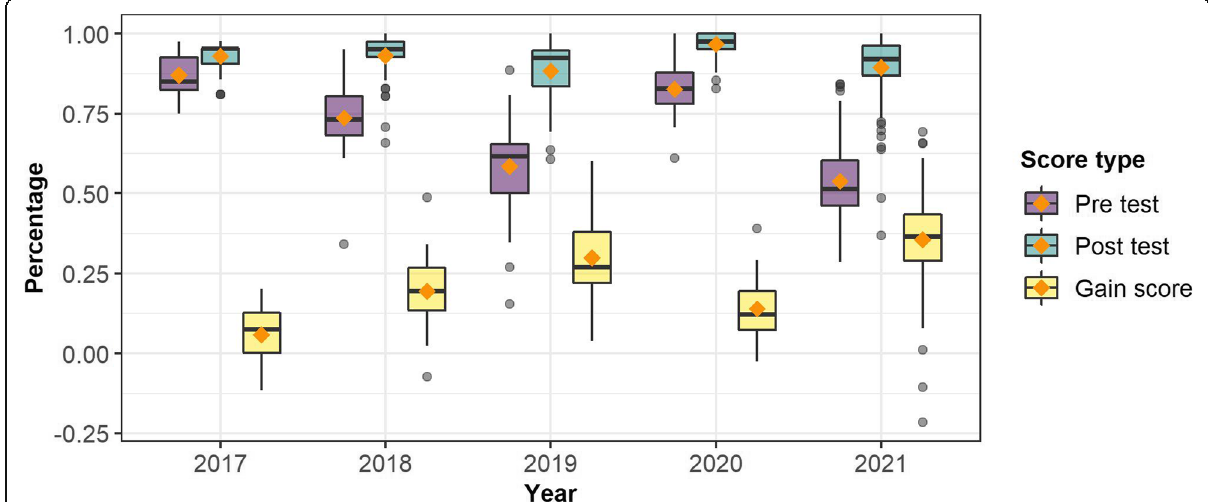
Fig. 1 Pre-test, Post-test, and Gain scores (shown as percentages)